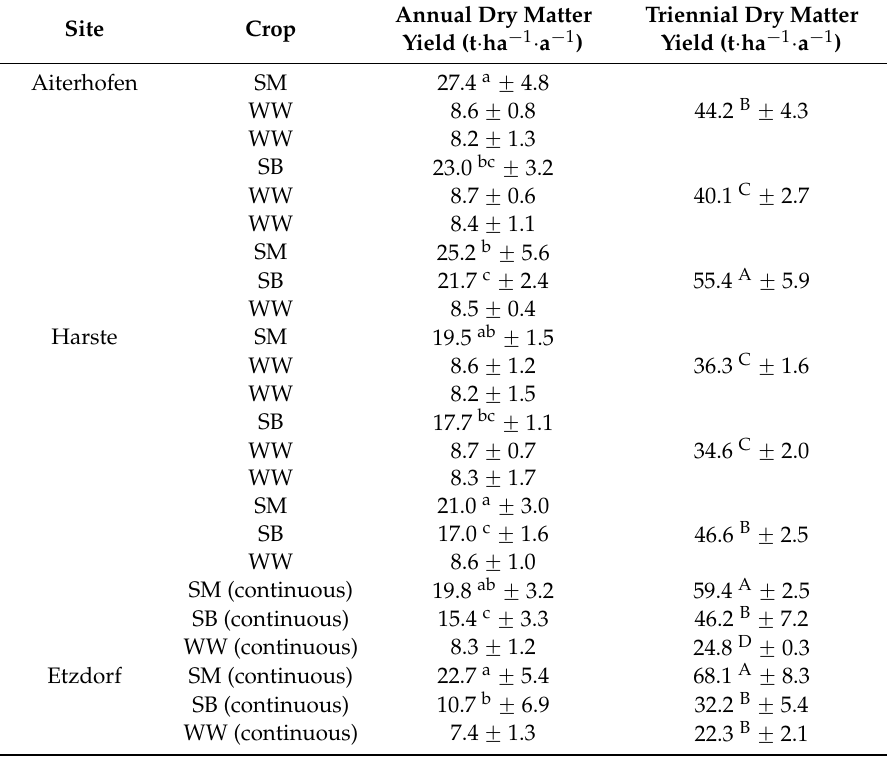
Annual and triennial dry matter yield per hectare of crops investigated per crop rotation/continuous cultivation at three experimental sites in Germany; mean values and standard deviation (2011–2013). Biomass crops: SM = silage maize; SB = sugar beet root; food crop: WW = winter wheat